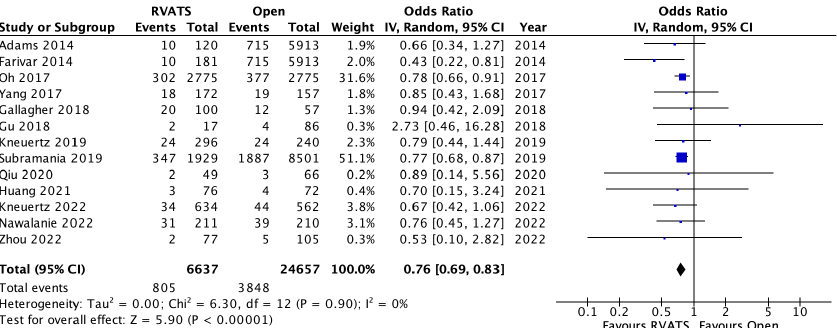
Figure 4. Atrial arrythmia in patients who underwent robotic video-assisted thoracoscopic surgery compared with open thoracotomy for resectable non-small cell lung cancer [7–9,11–14,17– 19,21,23,26].